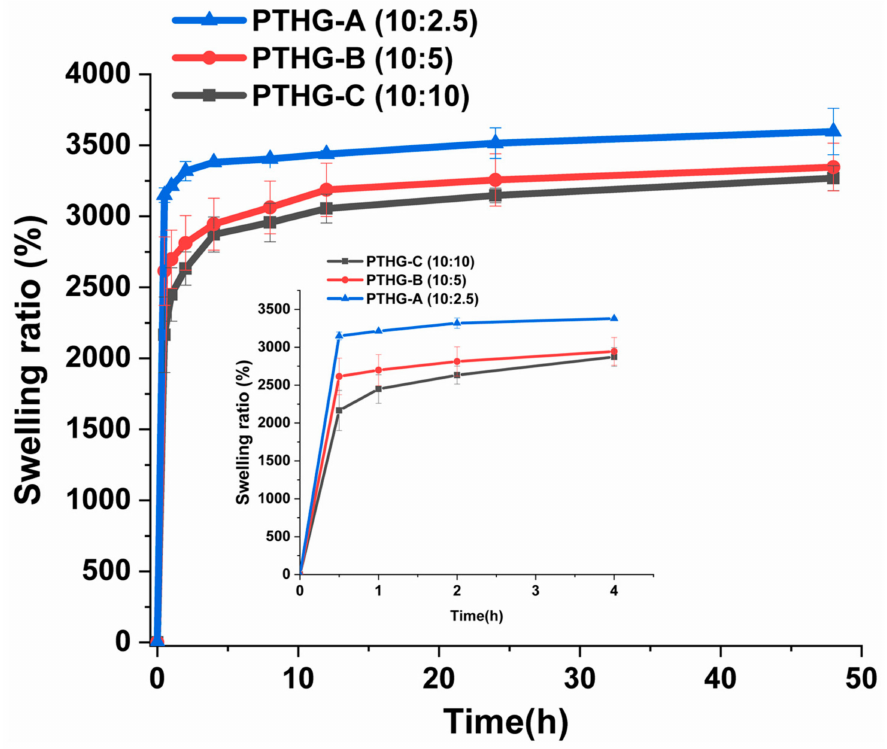
Figure 5. Swelling properties of hydrogels in PBS (pH 7.4). Inset showing swelling of hydrogels during initial 4 h. Error bars showing standard deviation (n =